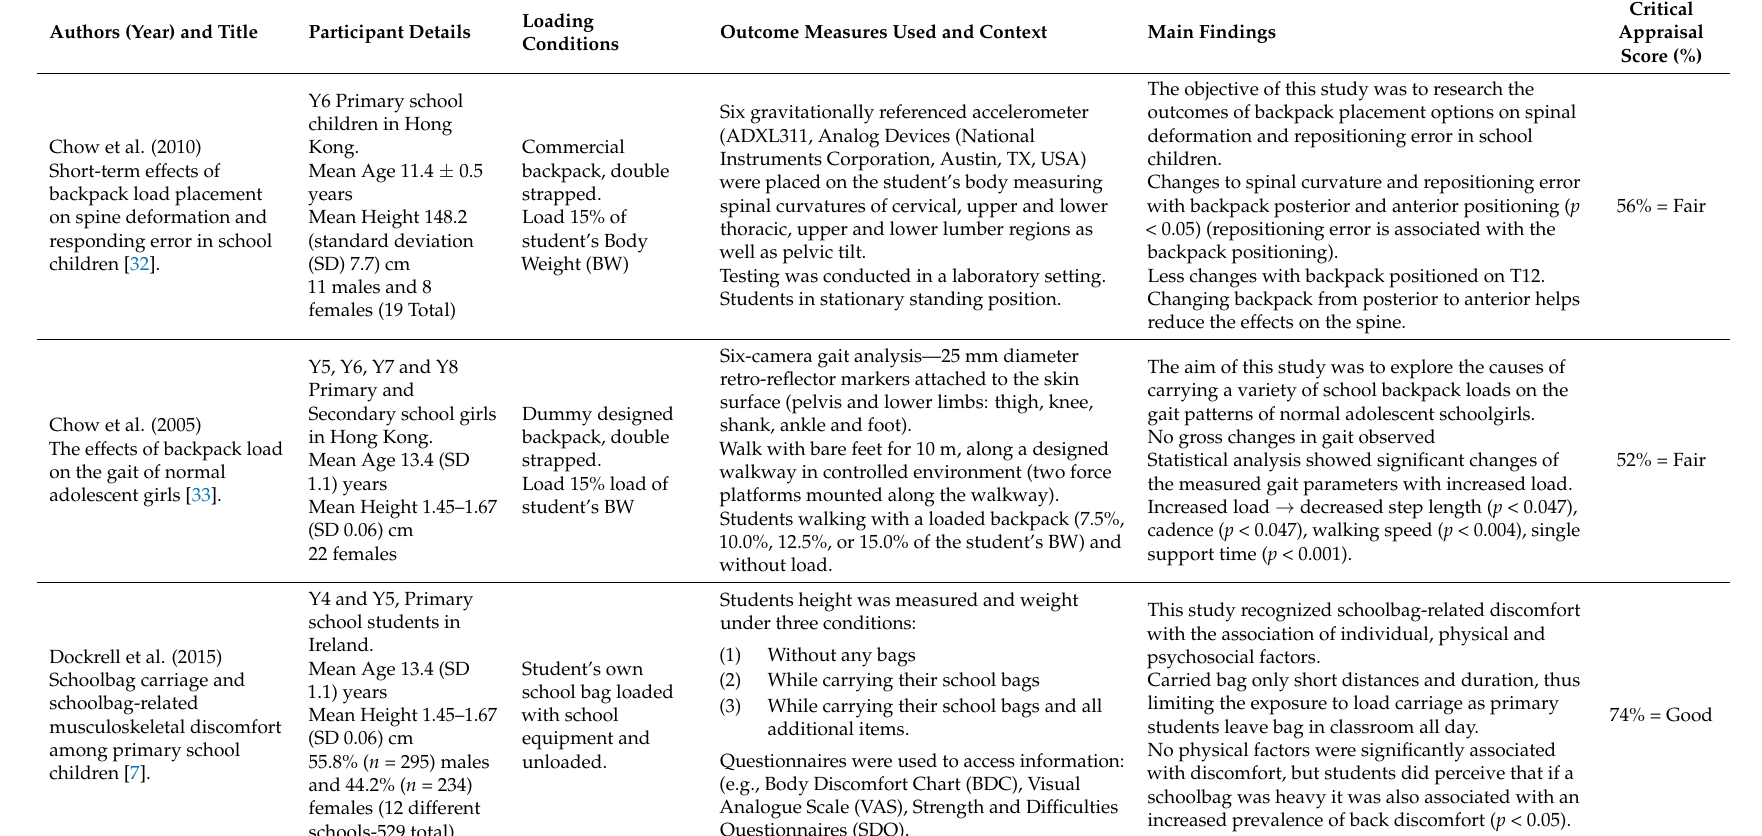
Table 2. Details and findings of included